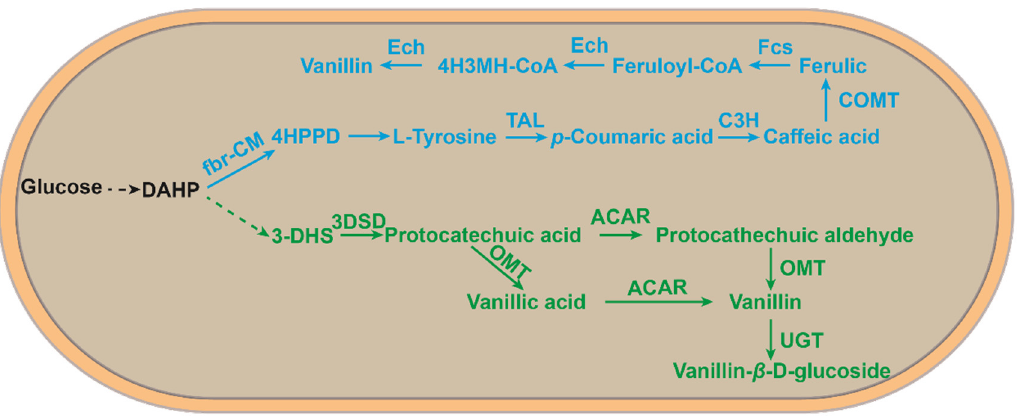
Figure 4. An artificial microbial route to de novo synthesis from glucose to vanillin. The blue part is a new vanillin synthesis route developed in E. coli by means of the L-tyrosine pathway [37]; the green part is a vanillin synthesis route developed in S. cerevisiae via the 3-dehydromangiferic acid pathway [39]. DAHP, 3-deoxy-d-arabino-heptulosonate-7-phosphate; 4-HPPD, 4-hydroxyphenylpyruvate; 4H3MH-CoA, 4-hydroxy-3-methoxyphenyl- β -hydroxypropionyl-CoA; 3-DHS,3-dehydroshikimate; Fbr-CM, fbr-chorismate mutase; TAL, tyrosine ammonia-lyase; C3H, 4-coumarate 3-hydroxylase; COMT, caffeate O-methyltransferase; FCS, feruloyl-CoA synthetase; ECH, enoyl-CoA hydratase/aldolase; 3DSD, 3-dedhydroshikimate dehydratase; ACAR, aryl carboxylic acid reductase; OMT, O-methyltransferase; UGT, UDP-glycosyltransferase.